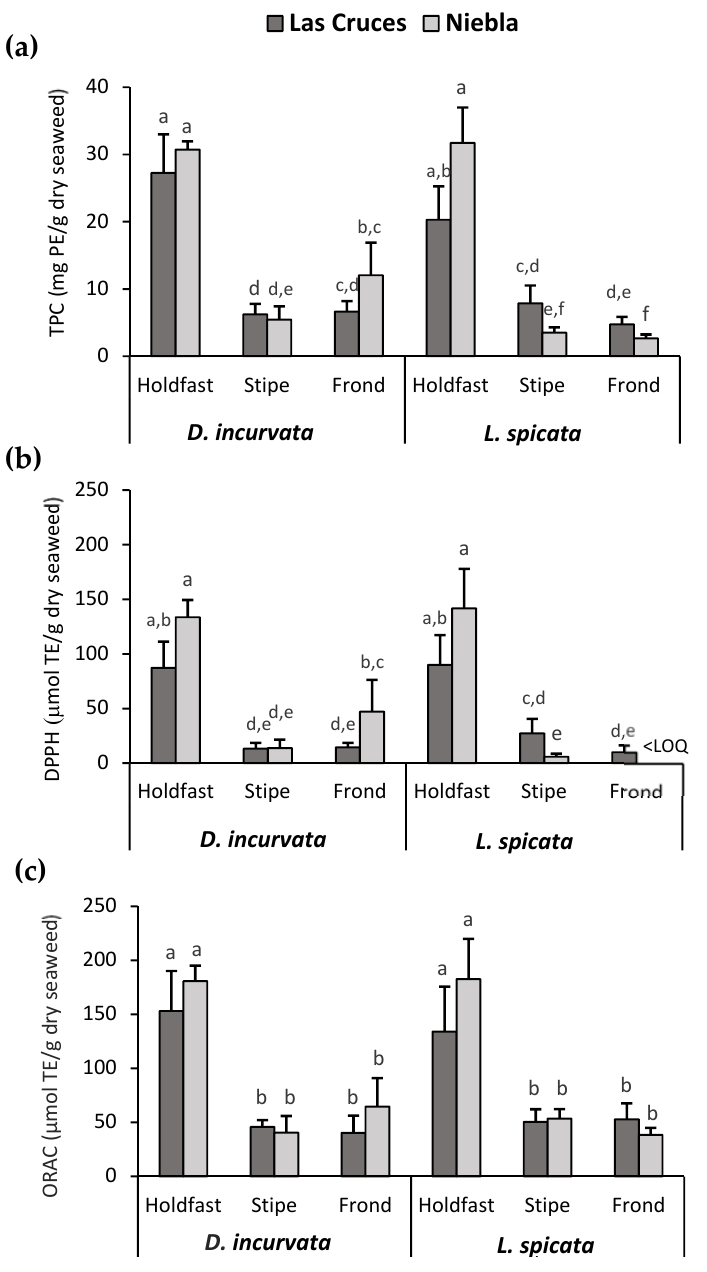
Figure 2. Spatial, anatomical, and interspecies variability of the phlorotannin content and antioxidant capacity of the seaweeds D. incurvata and L. spicata harvested in central (Las Cruces) and southern (Niebla) Chile. ( a ) The TPC (mg PE/g dry seaweed) and ( b , c ) the antioxidant capacity, quantified by DPPH RSA and ORAC ( µ mol TE/g dry seaweed), were determined in the PHLE extract. Bars represent the means ± SD of five replicates. Means were compared using one-way ANOVA and Tukey post hoc tests ( α ≤ 0.05). Different letters indicate significantly different groups for each response. <LOQ: below the limit of quantification.